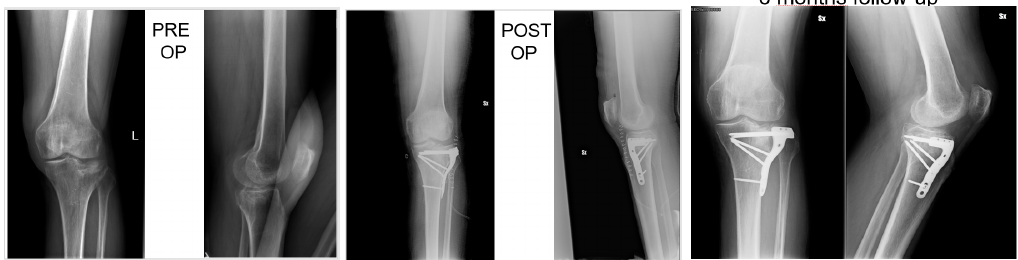
Figure 1. Fifty-seven-year-old patient, X-rays: preoperative, postoperative and control at 6 months follow up of a Shatzker type 2 fracture, AO 41 B1.3.